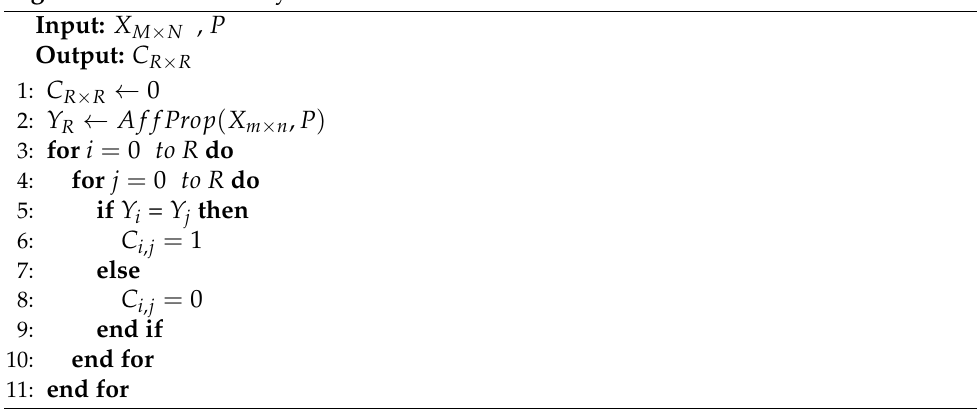
Algorithm 1 Connectivity Matrix